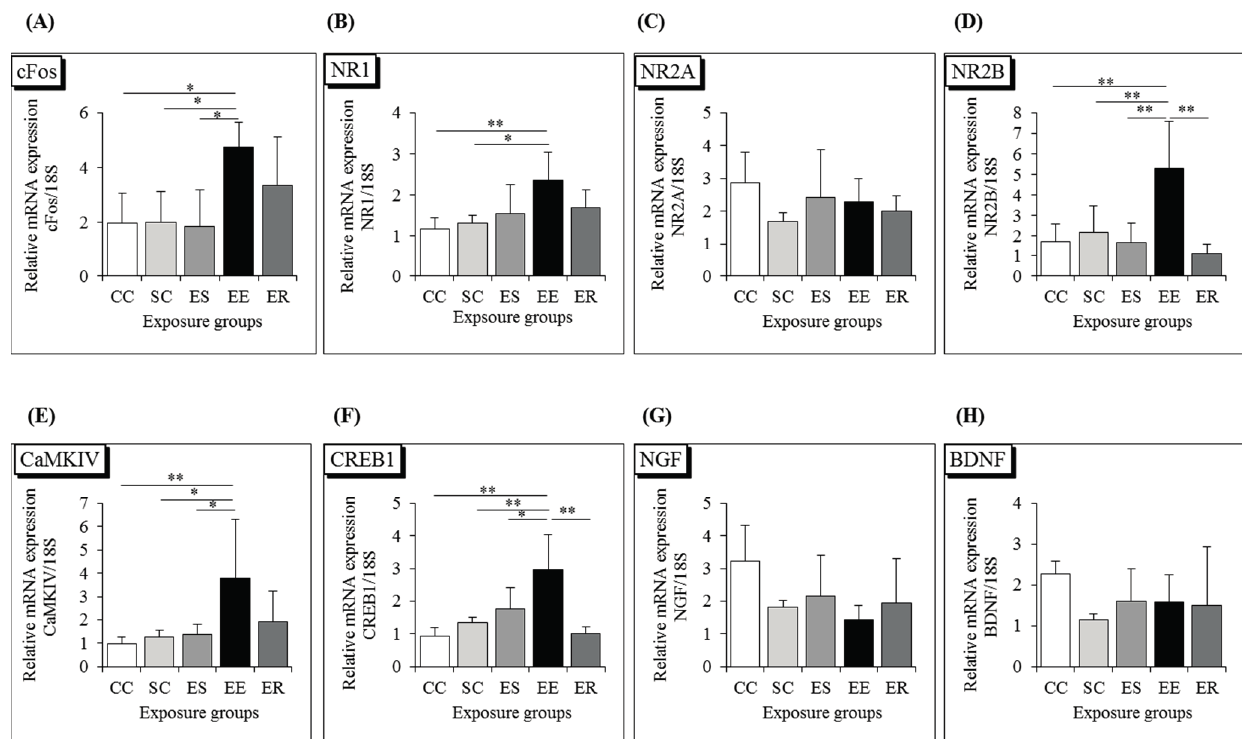
Figure 2. Messenger RNA expression level of ( A ) immediate early gene c-Fos, NMDA receptor subunits: ( B ) NR1, ( C ) NR2A, ( D ) NR2B, transcription factor: ( E ) CaMKIV, ( F ) CREB1, neurotrophins: ( G ) NGF, ( H ) BDNF in the hippocampi of CC, SC, EE, ES and ER groups of 7-week-old male mice. Each bar represents the mean ± SD ( n = 6, ** p < 0.01, * p < 0.05). CC, control-control; SC, sham-control; EE, exposed-exposed; ES,